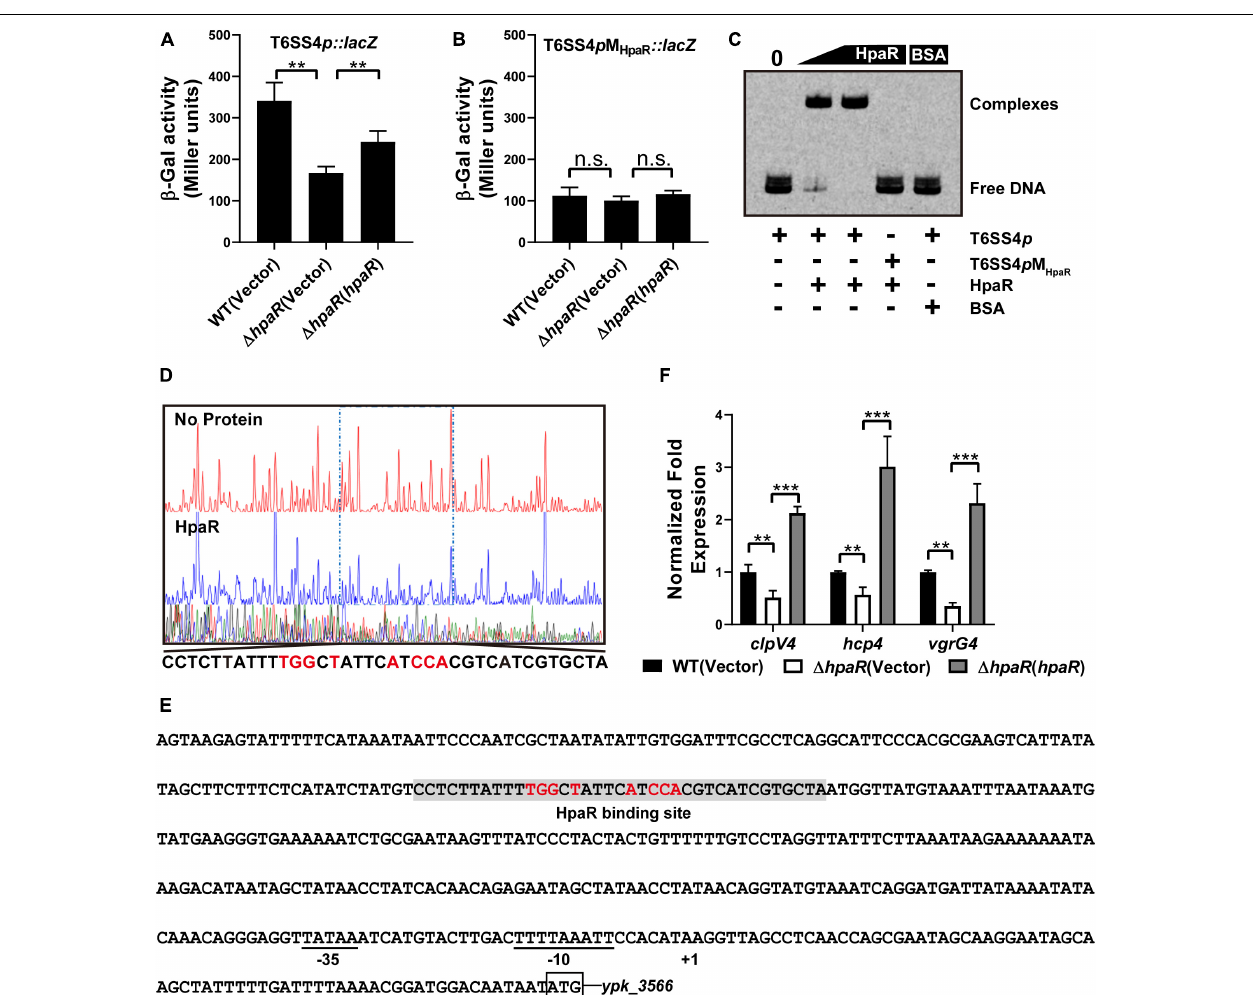
FIGURE 3 | HpaR positively regulates the T6SS4 expression in Y. pseudotuberculosis . β -galactosidase activity of the T6SS4 promoter (A) and T6SS4 promoter with mutations in the HpaR binding site (B) in Y. pseudotuberculosis Wild-type, (cid:49) hpaR mutant, and its complementary strain (cid:49) hpaR ( hpaR ). Data shown are the average of three independent experiments. The error bars indicate standard deviations of the average. ** P < 0.01; n.s., not significant. (C) EMSA was performed to analyze the interactions between His 6 -HpaR and the T6SS4 promoter (T6SS4 p ) or the promoter mutant identified His 6 -HpaR binding region (T6SS4 p M HpaR ). (D) Identification of the HpaR-binding site within the T6SS4 promoter using the DNase I footprinting assay. Letters in red denote inverted repeat sequences. (E) The HpaR binding site detected by DNase I footprinting assay were shown in the T6SS4 promoter region by shading. Letters in red denote inverted repeat